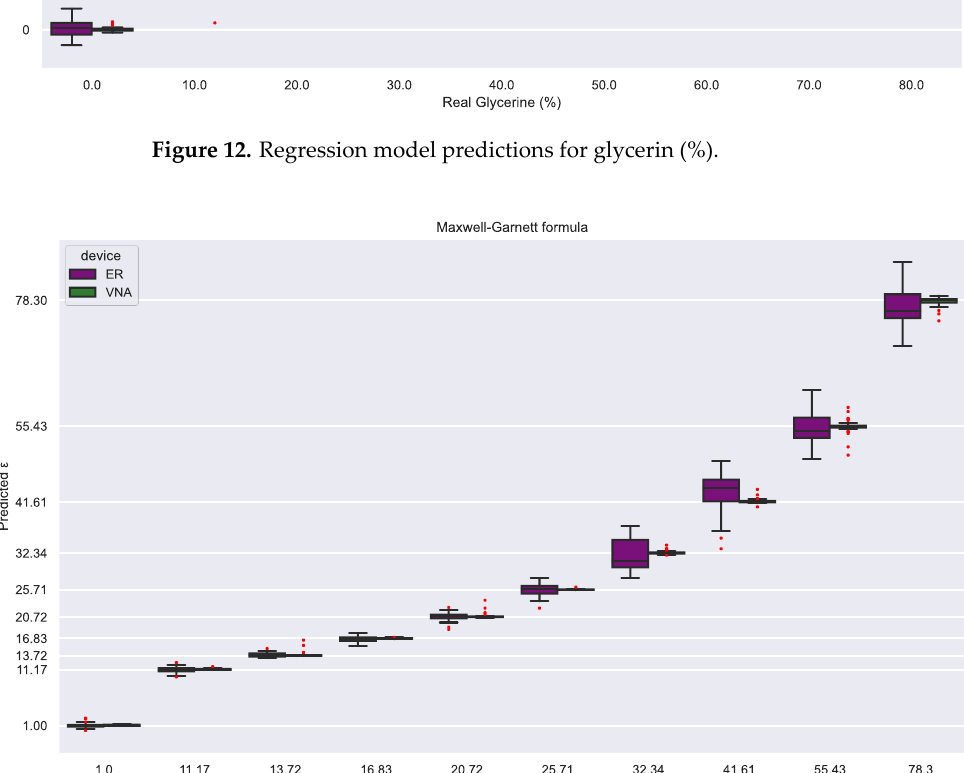
Figure 12. Regression model predictions for glycerin (%).